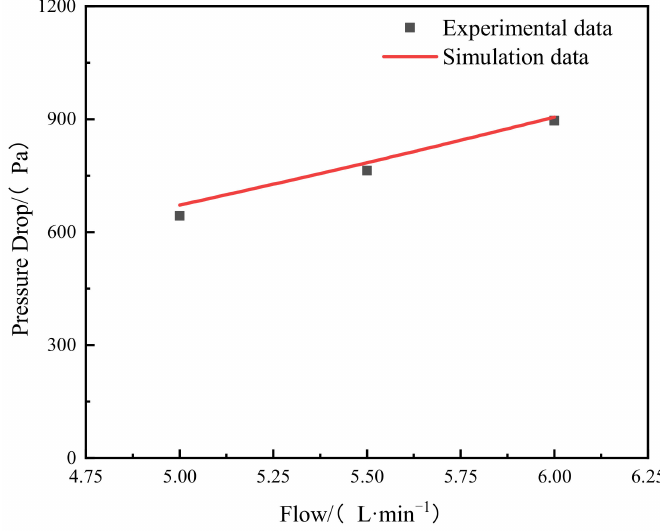
Figure 3. Pressure reduction: predicted vs.